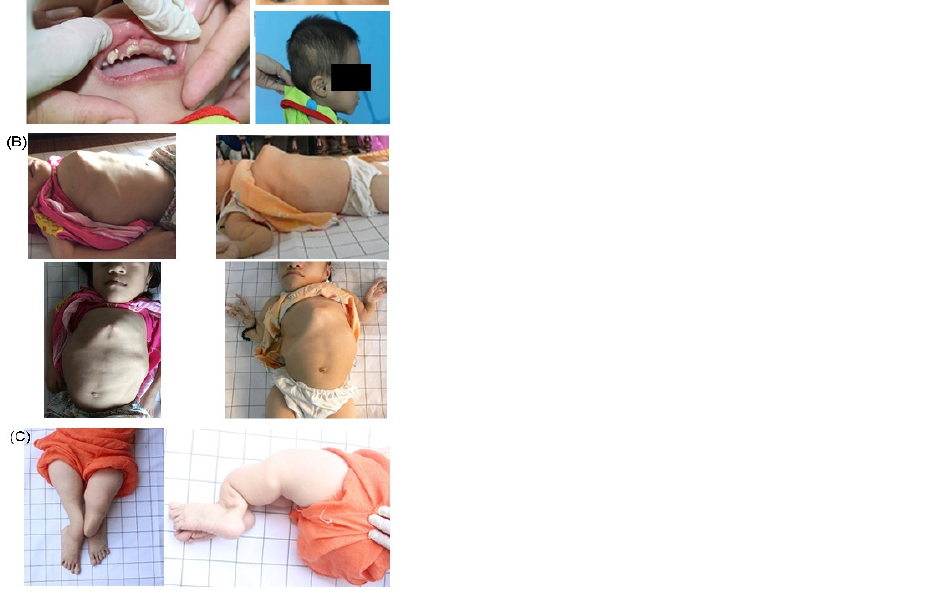
Figure 5. Clinical features of patients with P3H1 pathogenic variants. ( A ) Oral features, bluish eye sclera, craniosynostosis and low-set ears; ( B ) Pectus carinatum; ( C ) Lower limb deformities.